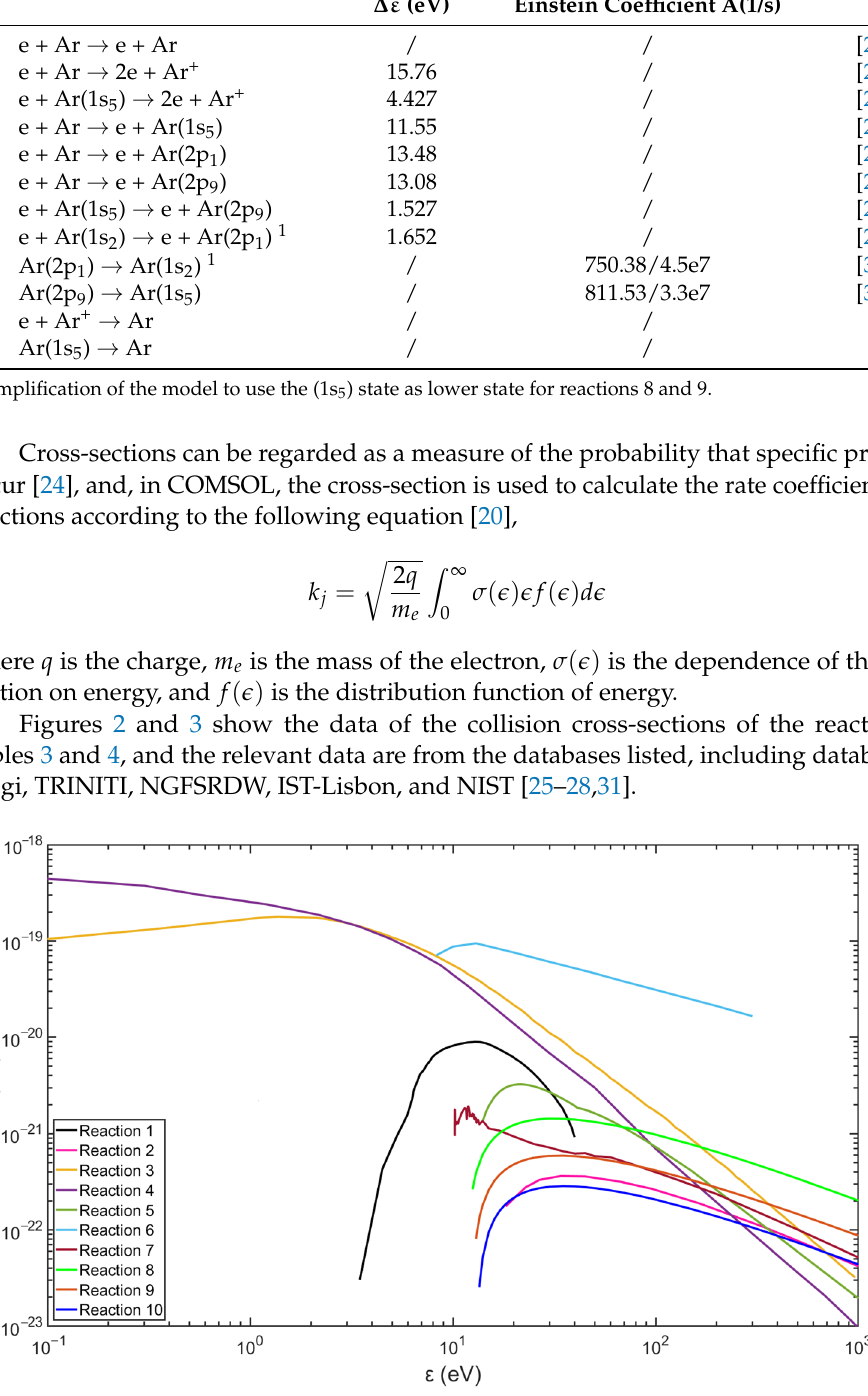
Figure 3. Collision cross-section of argon plasma reactions (data are from the databases listed in Table 4). 4. Results and Discussion 4.1. Characterization of Ar/H 2 Plasma with OES Figure 4 shows the spectrum for wavelengths between λ = 400 and 900 nm of Ar/H 2 plasma, mixing with 35% hydrogen (volume flow under standard conditions) at an input of electrical power of 165 W and a pressure of 5 Pa. The Balmer lines are distinct enough to be evaluated. From the measurement result, the intensity of H α is much stronger than that of the other two lines, which means that reaction 11 in Table 3 is the most prone tran- sition [32]. The mixing ratio of Ar/H 2 is important for the properties of the plasma. The Ar/H 2 mixture was controlled by the MFCs, and the spectra were measured after the plasma was ignited. As Figure 5 shows, the intensities of the Balmer lines are sensitive to changes in the mixing ratio, while the intensities of the two typical argon lines do not change in the